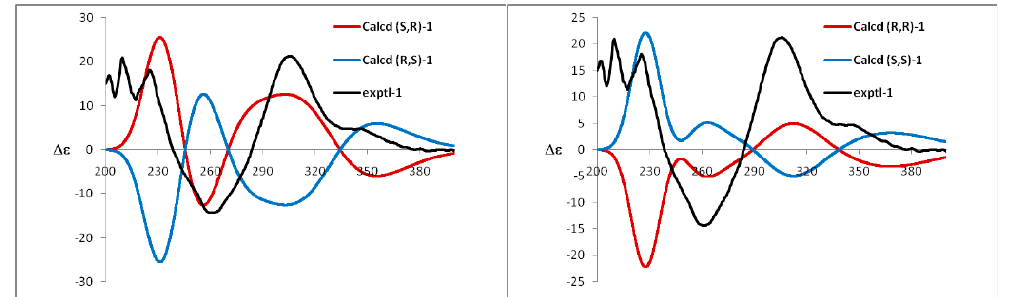
Figure 4. Experimental and calculated ECD spectra of compound 1 .